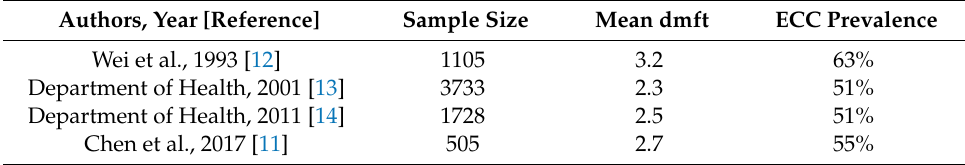
Table 1. ECC experience (dmft) and prevalence of 5-year-old Hong Kong